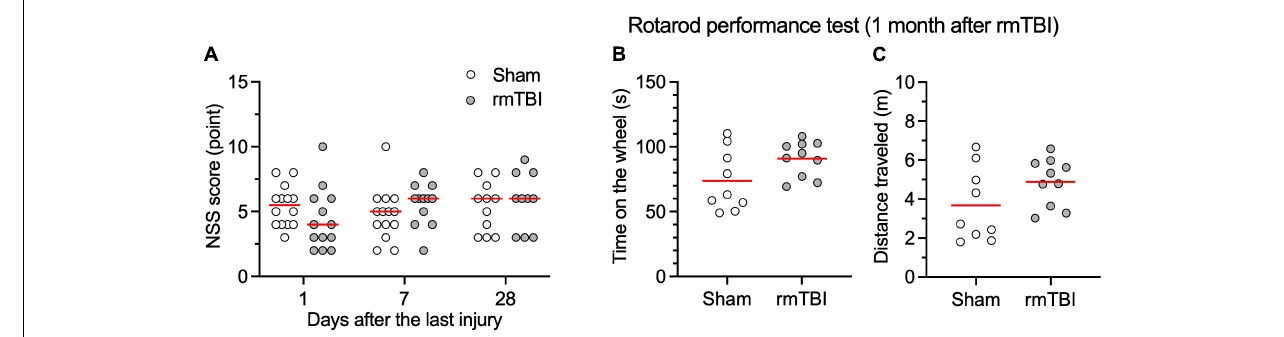
FIGURE 2 | rmTBI on NSS (A) , rotarod performance test (B,C) . Rats with rmTBI did not show difference in neurological impairment (A) , total time on the wheel (B) ; and total distance traveled (C) in the rotarod performance test from rats with sham injury. Black bars in the figure represent mean. Each dot represents data one